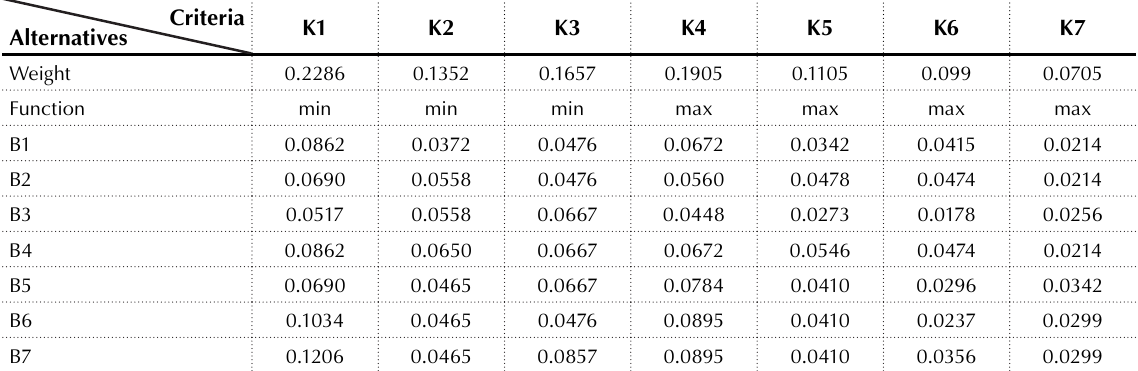
Source: Compiled by